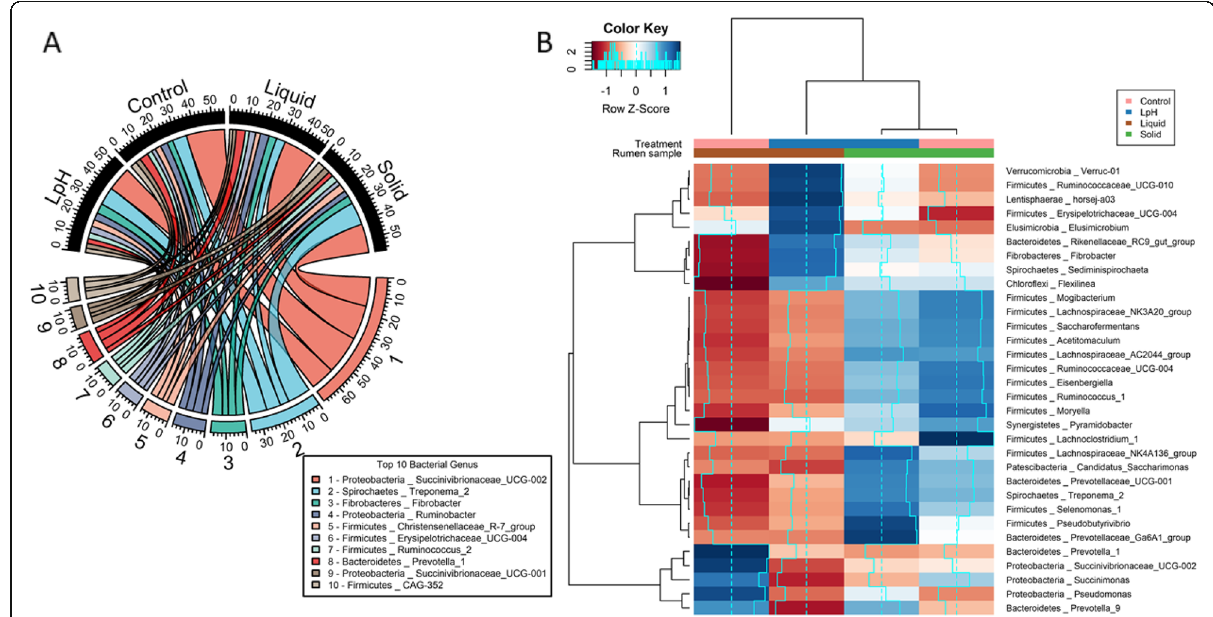
Fig. 4 Taxonomic composition of the ruminal microbiome in the liquid and solid fractions in response to normal and low pH treatments. The top 10 bacterial genus were selected, and sequences were expressed as relative abundance ( a ). The heatmap shows bacterial genera that were significantly affected by pH and by sample fraction ( b ). Rows are color coded according to Z -score. A Z -score change of + 1 is equal to one standard deviation above the row mean. Blue represents upregulation, and red represents